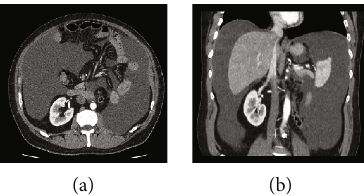
Figure 2: Computed tomography scan. Massive ascites can be seen in the (a) axial and (b) coronal